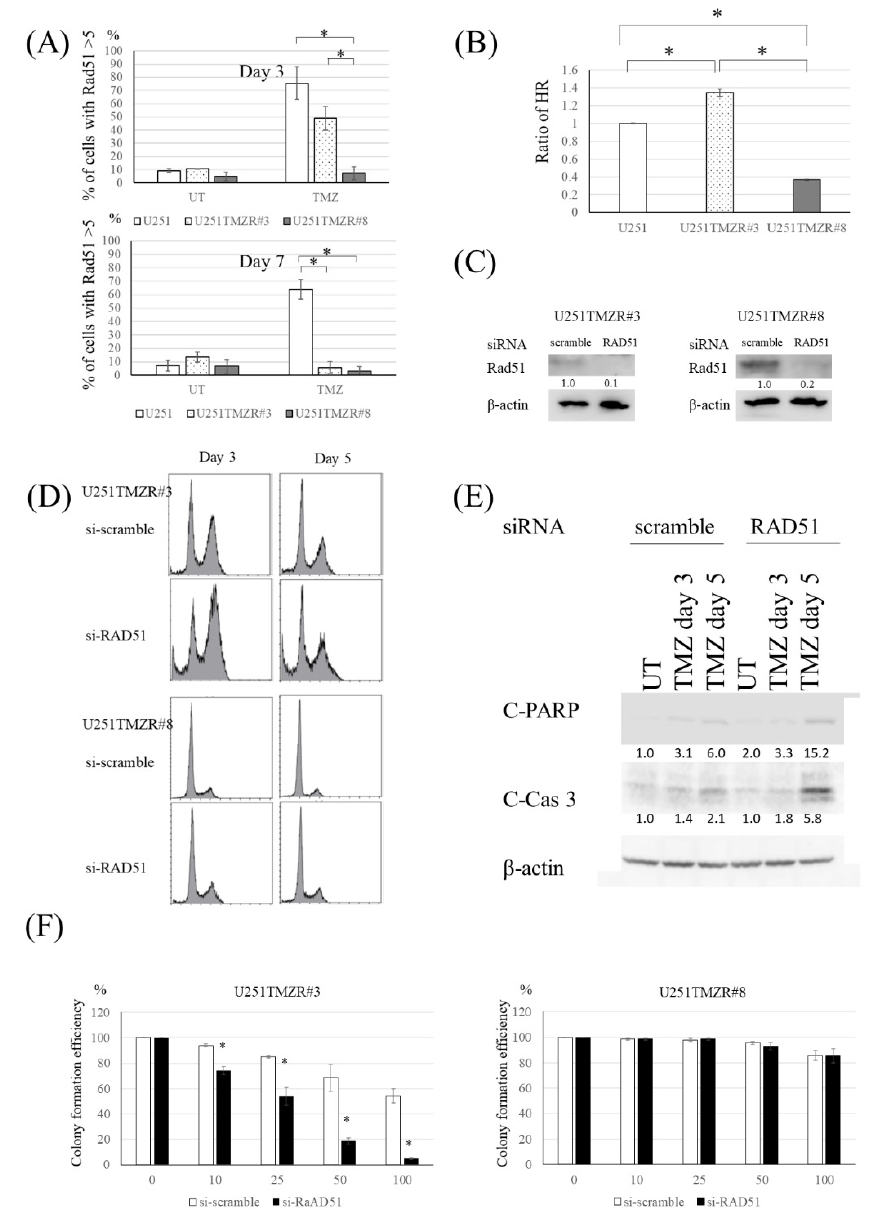
Figure 2. Inhibition of HR resensitized the TMZ-resistant U251 cells harboring high HR to TMZ. ( A ) Quantitative data from immunofluorescence analysis of Rad51 foci in U251, U251TMZR#3, and U251TMZR#8 cells 3 and 7 days after TMZ exposure (100 µ M, 3 h). ( B ) Homologous recombination activity as determined by an in vivo plasmid-based recombination reporter assay. Value of the U251 cells was set at 1. ( C ) Western blot analysis of RAD51 and β -actin levels in U251TMZR#3 and U251TMZR#8 cells three days following exposure to scramble or RAD51-targeting siRNA. ( D ) Fluorescence-activated cell sorting analysis of cell cycle distribution in control and RAD51-suppressed U251TMZR#3 and #8 cells 3 and 5 days after TMZ exposure (100 µ M, 3 h). ( E ) Western blot analysis of cleaved PARP, C-leaved caspase 3, and β -actin levels in U251 parental, U251TMZR#3, and U251TMZR#8 cells. ( F ) Colony formation efficiency of control and RAD51-suppressed U251TMZR#3 and #8 cells following TMZ exposure (0–100 μ M, 3 h)., * p < 0.05.